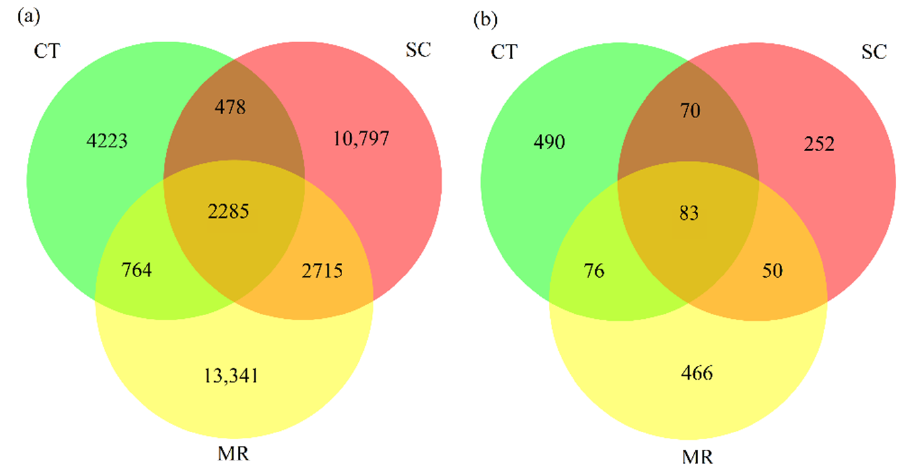
Figure 2. Venn diagrams depicting the number of shared and unique ( a ) bacterial and ( b ) fungal amplicon sequence variants (ASVs) among treatments. Each circle represents sampled compartments. Values within intersections represent shared ASVs, values outside intersections represent unique ASVs.